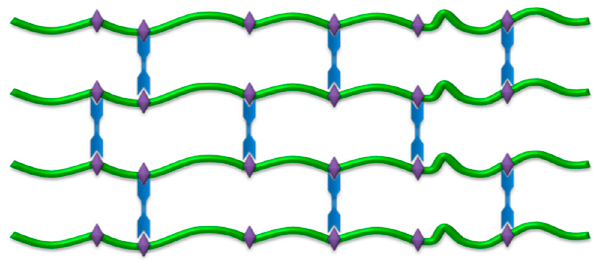
Figure 3. 3D hydrogel network showing its macroporous structure. Main polymer chain (green); covalent bonds formed during crosslinking and polymerization process (blue); crosslinking points in the polymer structure (violet).